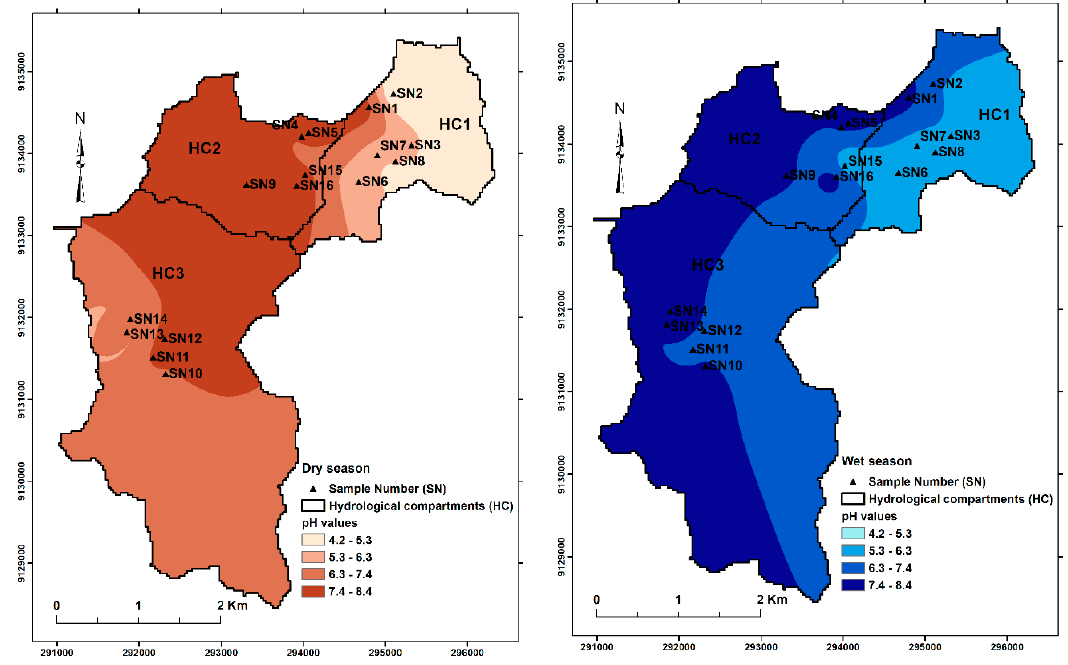
Figure 2. Spatial distribution of pH on the dry and wet seasons in the three hydrological compartments.